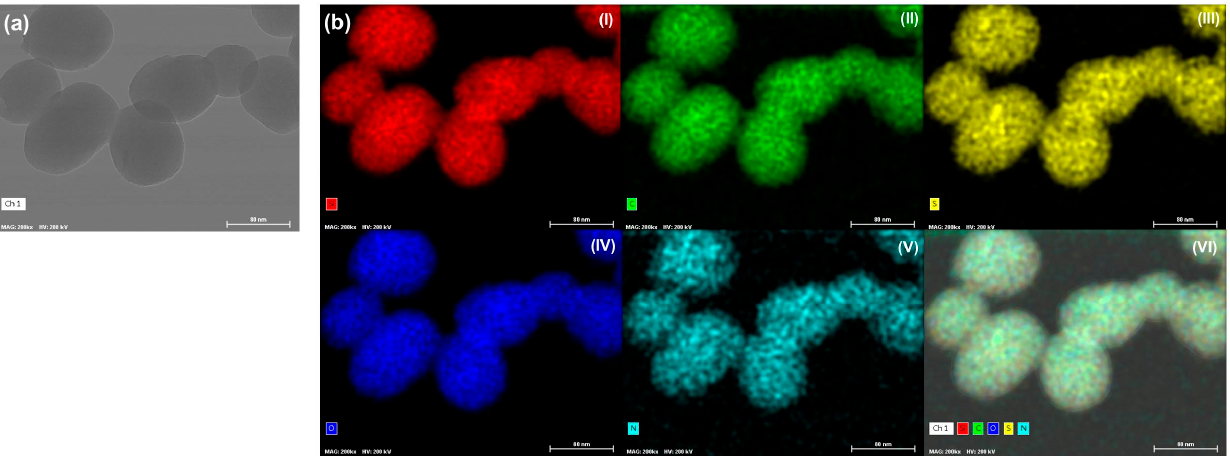
Figure 5. Morphology and elemental mapping analyses for TMSN-NH 2 functionalized with tri- antennary GalNAc cluster (scale bar = 80 nm). TEM image ( a ) and EDS maps ( b ): ( I ) silicon (red), ( II ) carbon (green), ( III ) sulfur (yellow), ( IV ) oxygen (dark blue), ( V ) nitrogen (light blue), and ( VI ) overlay image of images ( I – V